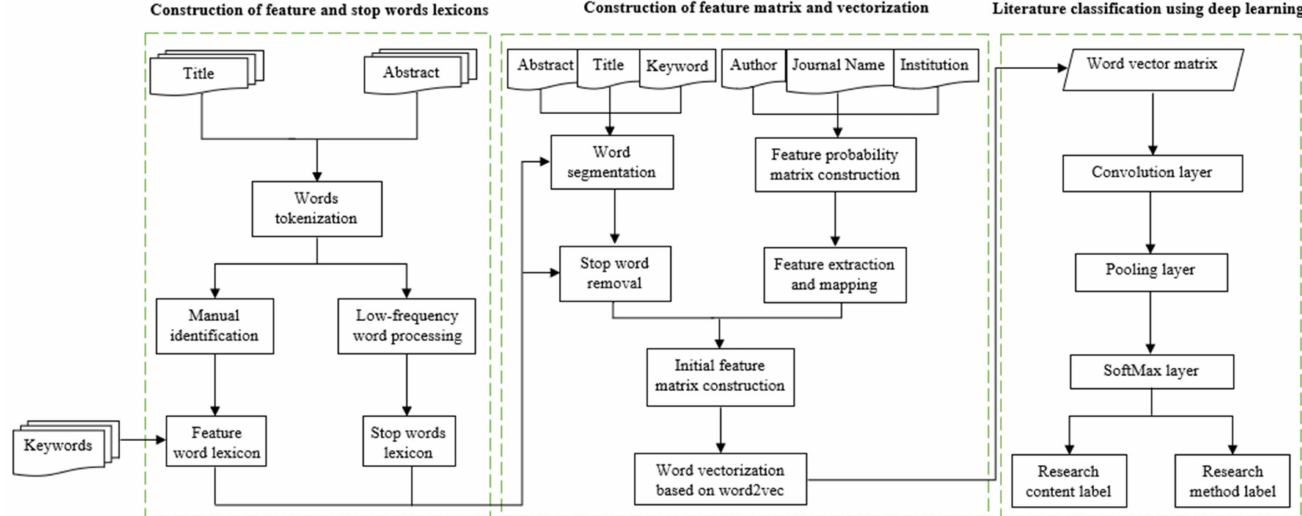
Figure 1. Scientometric analysis and classification of scientific literature using